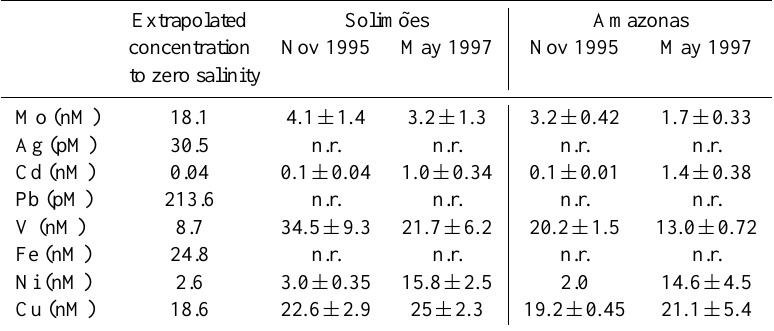
Table 1. Hypothetical end-member metal concentrations in the upper Amazon River Basin. Values are compared with concentrations reported in the upper Amazon River Basin by Seyler and Boaventura (2003). n.r.: not